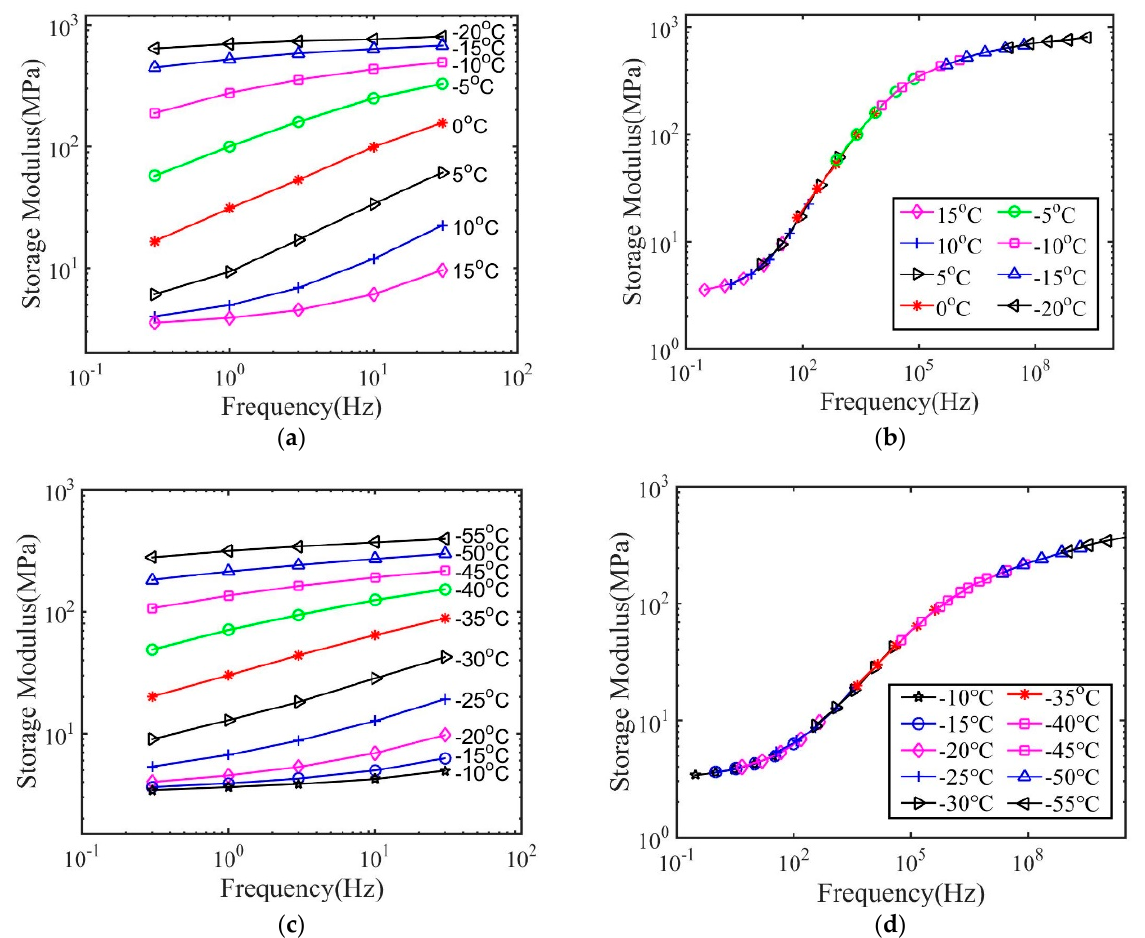
Figure 7. The storage modulus for polymers with 20 wt.% crosslink density and treatment by IPA for ( a ) 1 h and ( c ) 10 h, and the master curve for ( b ) 1 h and ( d ) 10 h.